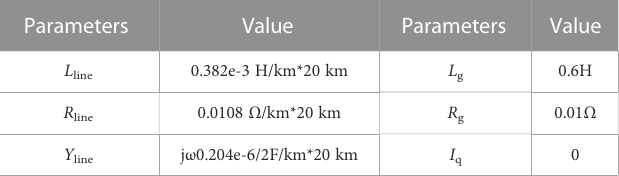
TABLE 2 I d - U PCC curve calculation parameters settings in Figure 3.